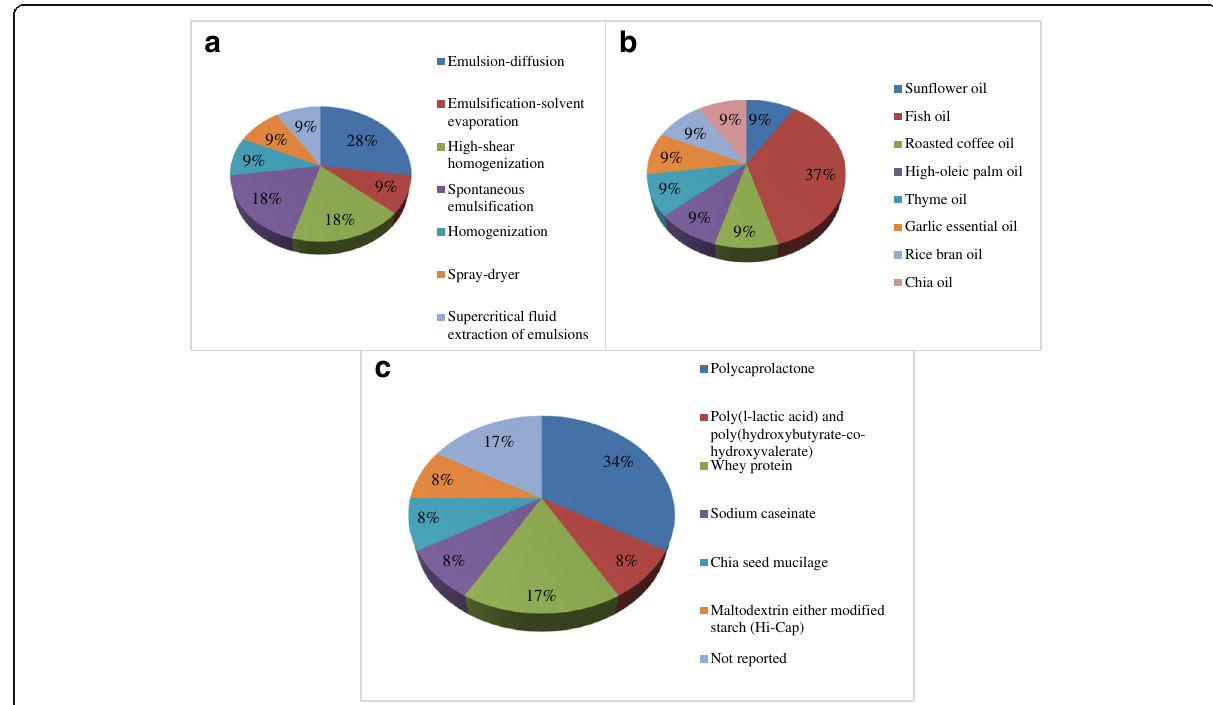
Fig. 3 Proposal and techniques ( a ), employed oils ( b ), and wall materials ( c ) of some studies using oil nanoencapsulation in